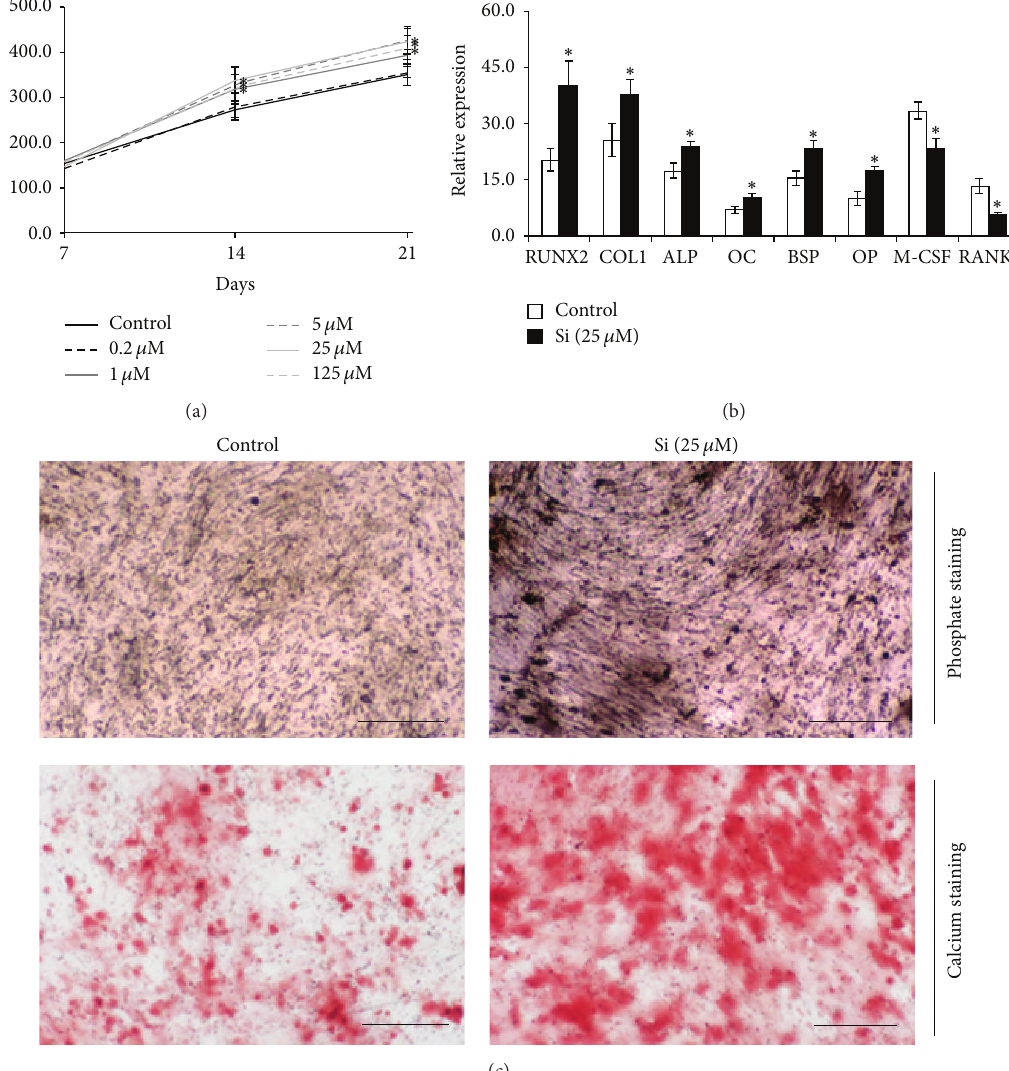
Figure 2: Effects of Si on the differentiation and function of hMSC. (a) ALP activity, determined by p NPP hydrolysis assay. (b) qPCR analysis of cell cultures maintained in the absence (control) or presence of Si (25 𝜇 M); (c) presence of phosphate and calcium deposits in cell layers, by von Kossa and alizarin red staining, respectively. ∗ Significantly different than the control. Black bars represent 300 𝜇